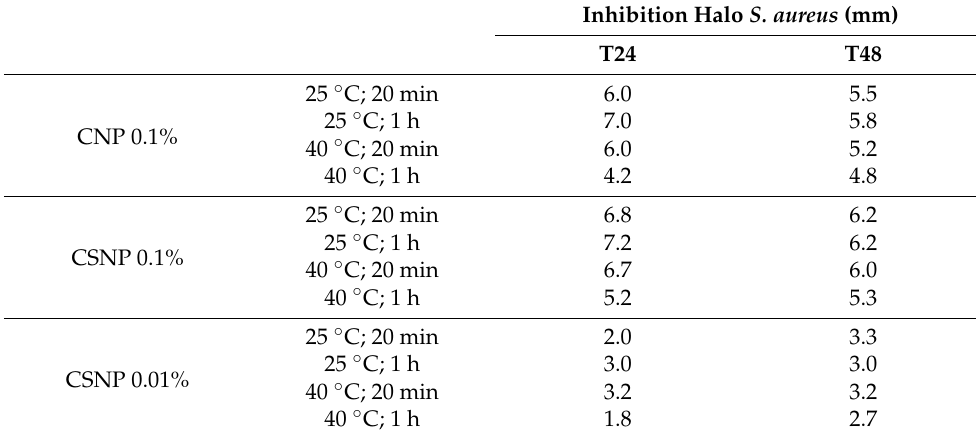
Table 3. Inhibition halos (mm) of the antimicrobial tests in leather samples at phase E treated with chitosan nano/microformulations: CNP 0.1%, CSNP 0.1%, and CSNP 0.01%, against S. aureus. Incorporations were run at different temperatures and times. The measure of the inhibition halo corresponds to the halo after subtracting the control (leather).